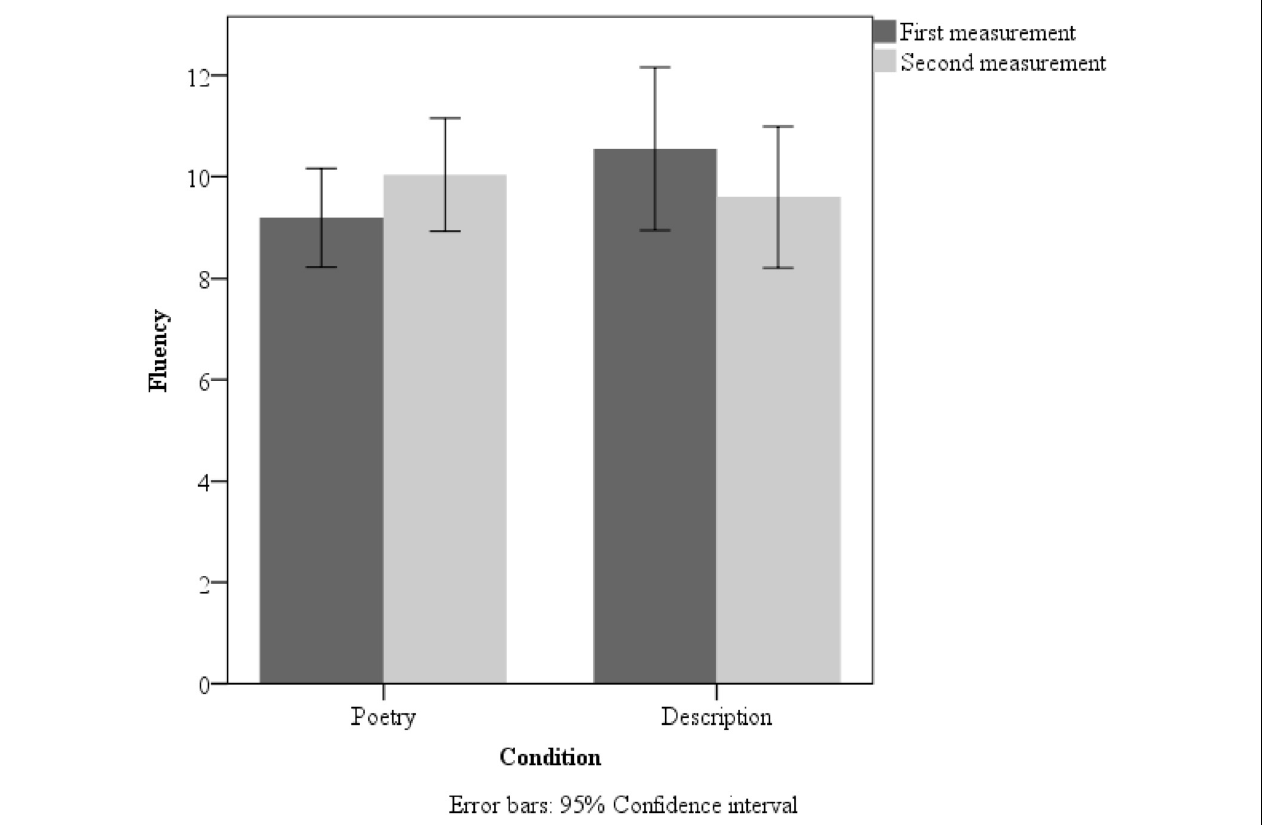
FIGURE 1 | Mean fluency scores in the poetry-reading group and description-reading group in the first and second measurement in Study 1. Error bars: 95% Confidence interval.